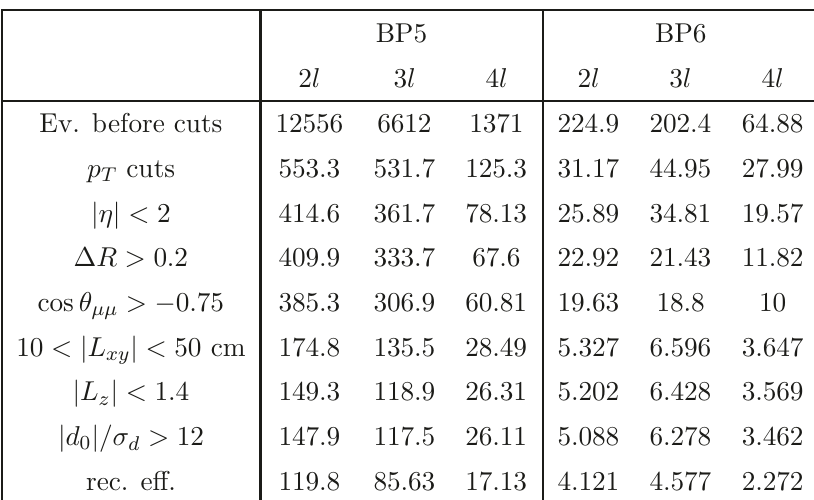
H 2 ν h ν h ) multiplied → →